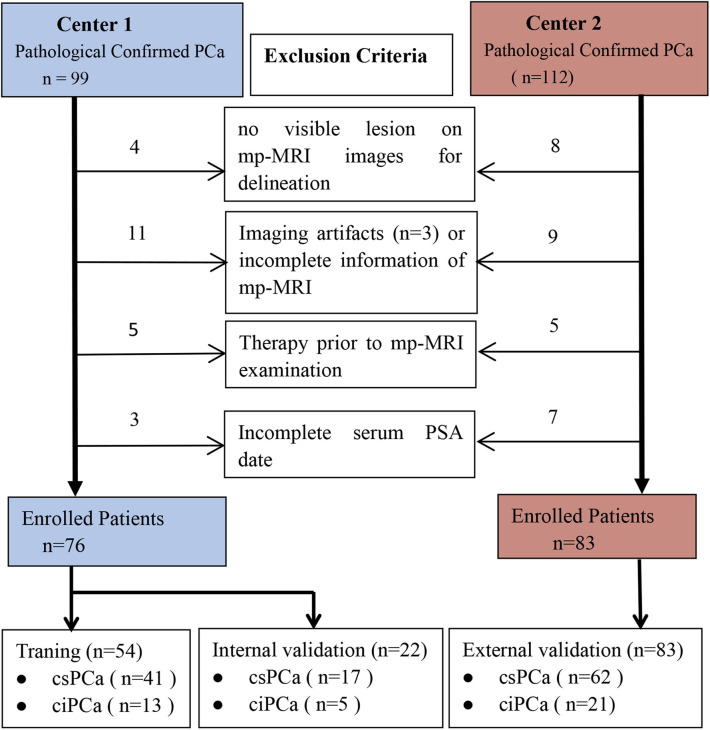
Diagram for inclusion of patients into the study. csPCa, clinically significant prostate cancer; ciPCa, clinically insignificant prostate cancer; mp-MRI, multi-parametric MRI; PSA, prostate-specific antigen.